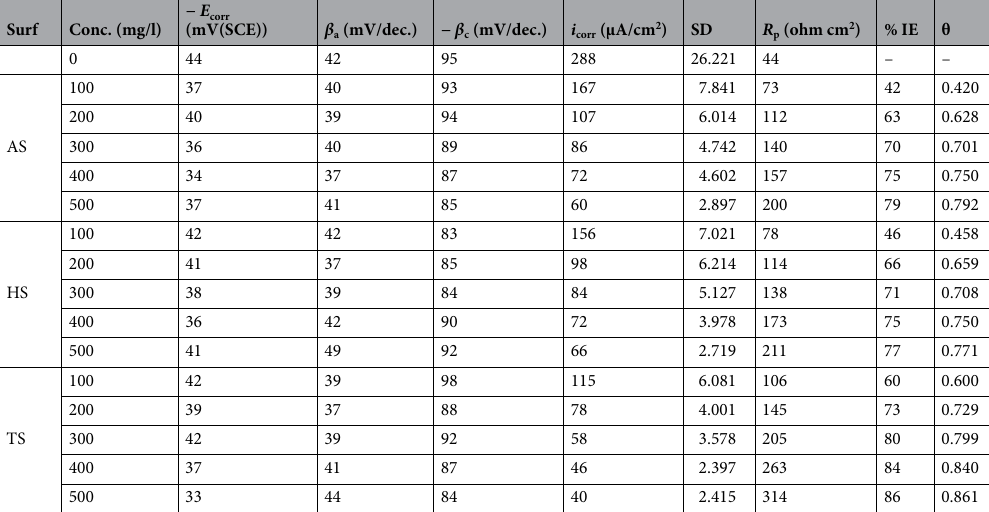
Table 3. Polarization parameters for the copper corrosion in 1.0 M H 2 SO 4 solution and in the presence of the examined surfactants at 298 K. AS sodium N-dodecyl asparagine, HS sodium N-dodecyl histidine, TS sodium N-dodecyl